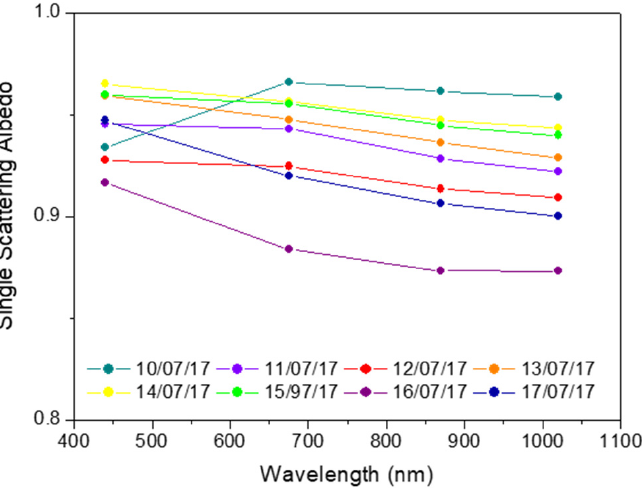
Figure 10. Spectral dependence of the single scattering albedo (SSA) for biomass burning and desert dust episodes that occurred in the period 10–17 of July in Naples.